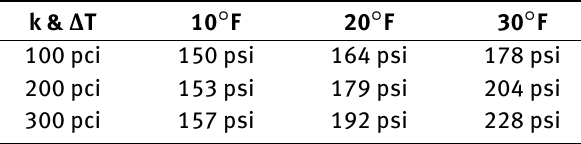
pci and from 200 pci to 300 pci) will result in increased Table 2: Combinations for KENPAVE